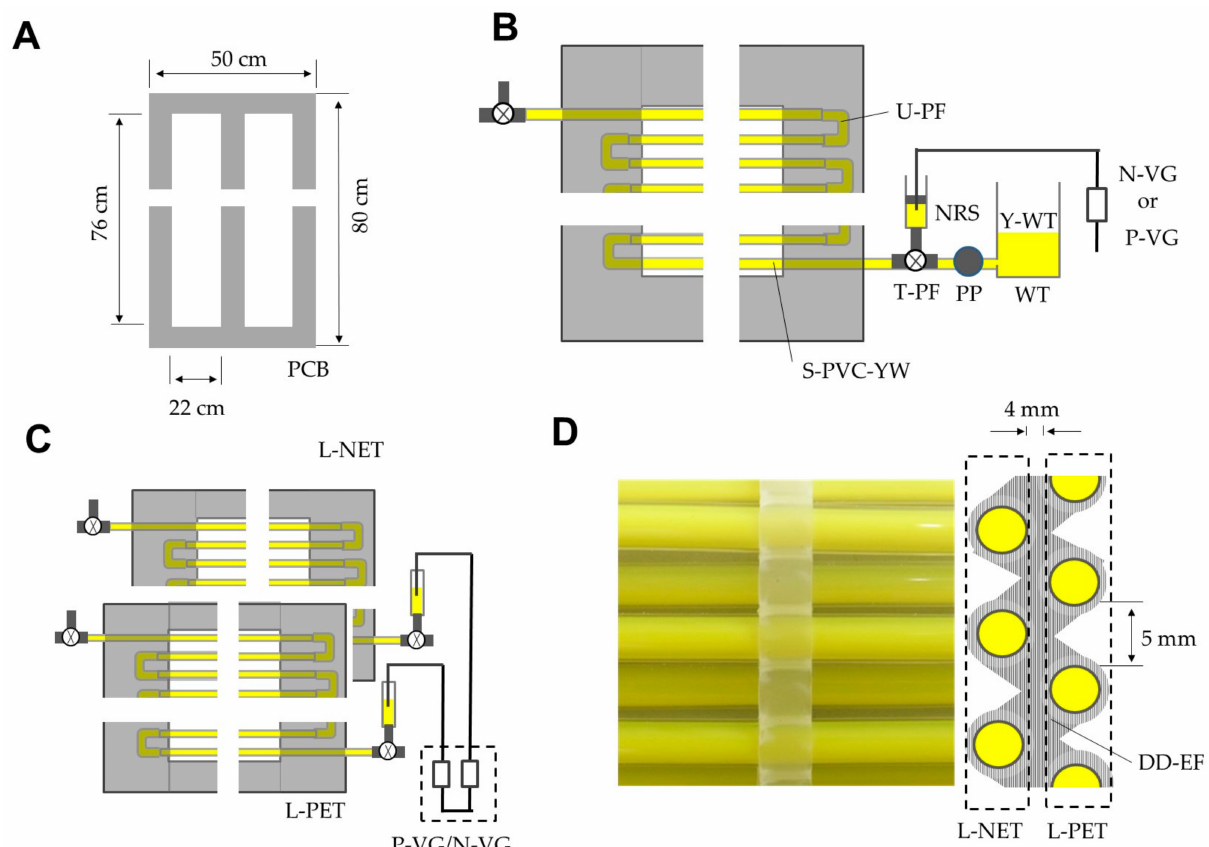
Figure 1. ( A ) A plastic cardboard frame holding soft polyvinyl chloride (S-PVC) tubes. ( B ) S- PVC tubes linked to each other using U-shaped pipe fittings and filled with yellow-colored water negatively or positively charged by an iron wire. One end was linked to a negative or positive voltage generator and the opposite end was in contact with the water via a needle-free syringe. ( C ) Two layers of S-PVC tubes with opposite electrifications were coupled to construct the yellow-colored double-charged dipolar electric field screen (YDD-EFS). The negative and positive voltage generators were combined in a box that obviated the need for a ground line. ( D ) Photograph of the YDD-EFS (left) and schematic of the electric field in the space between the oppositely electrified tubes (right) (cross-sectional view). Abbreviations: PCB, polypropylene cardboard; U-PE, U-shaped pipe fitting; S-PVC-YW, soft PVC chloride tube filled with yellow-colored water; NRS, needle-free syringe; T-PF, T-shaped pipe fitting; PP, peristaltic pump; WT, water tank; Y-WT, yellow-colored water; L-PET, layer of positively electrified tubes; L-NET, layer of negatively electrified tubes; P-VG/N-VG, positive and negative voltage generators in one box, respectively; DD-EF, double-charged dipolar electric